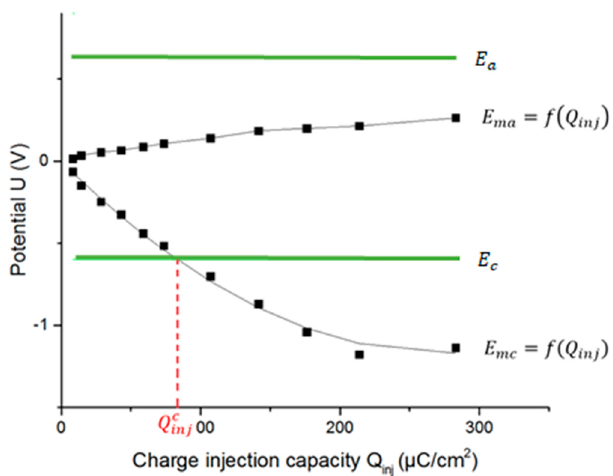
Figure 9. Determination of CIC for electrode A by calculating intersections of functions (cid:1831) (cid:3040)(cid:3028) = (cid:17) (cid:16) (cid:1858)((cid:1843) (cid:3036)(cid:3041)(cid:3037) ) and (cid:1831) (cid:3040)(cid:3030) = (cid:1858)((cid:1843) (cid:3036)(cid:3041)(cid:3037) ) with their relevant electrochemical potential window limits ((cid:1831) (cid:3028) and (cid:1831) (cid:3030) ) .